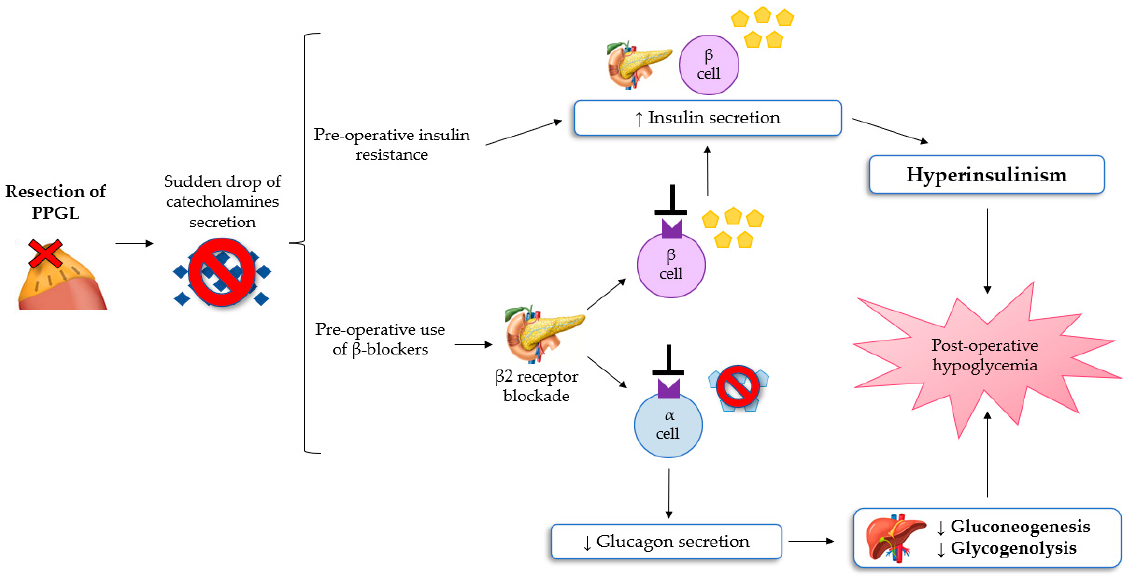
Figure 2. The mechanisms of hypoglycemia after surgery for PPGL [8,11,32,33]. Abbreviations: PPGL, Pheochromocytomas and